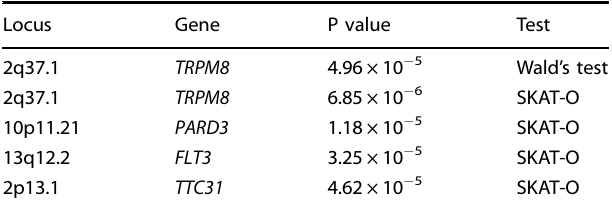
Table 2. Gene-based rare variant association